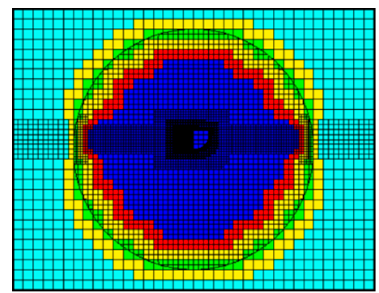
Figure 2. Four types of cells.